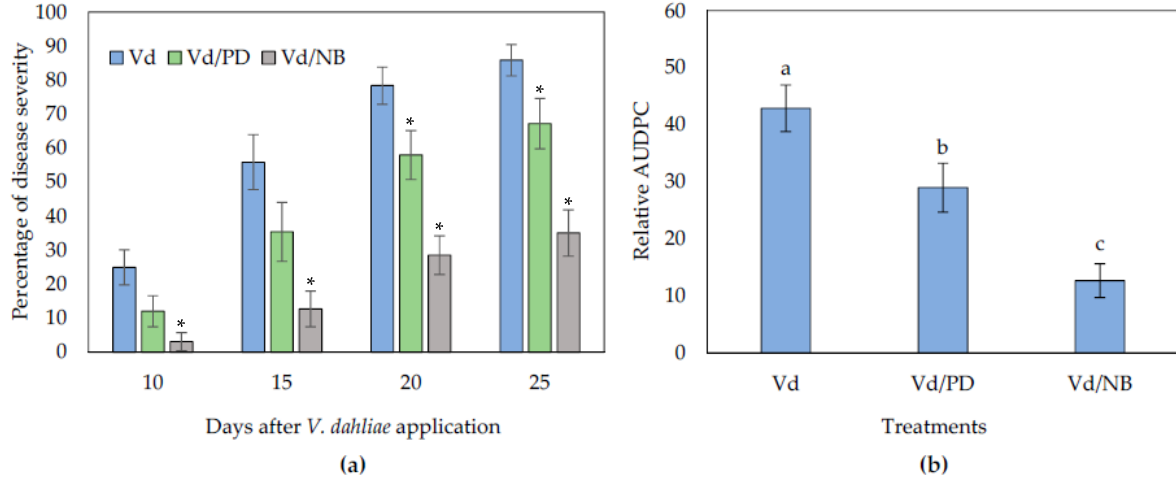
Figure 2. Verticillium disease severity ( a ) and relative AUDPC ( b ), caused by artificial inoculation of V. dahliae (Vd), on eggplants grown in non-sterilized soil substrate amended with PD and NB. Each treatment consisted of 10 plants and the experiment was repeated three times. Columns represent means of the three replications ( n = 30 plants) and the vertical bars indicate standard errors. For disease severity ( a ), columns with asterisks (*) are significantly different ( p < 0.05) from control (Vd) according to t -test, for each time-point; for relative AUDPC ( b ), columns with different letters are significantly different ( p < 0.05) from each other according to LSD test.